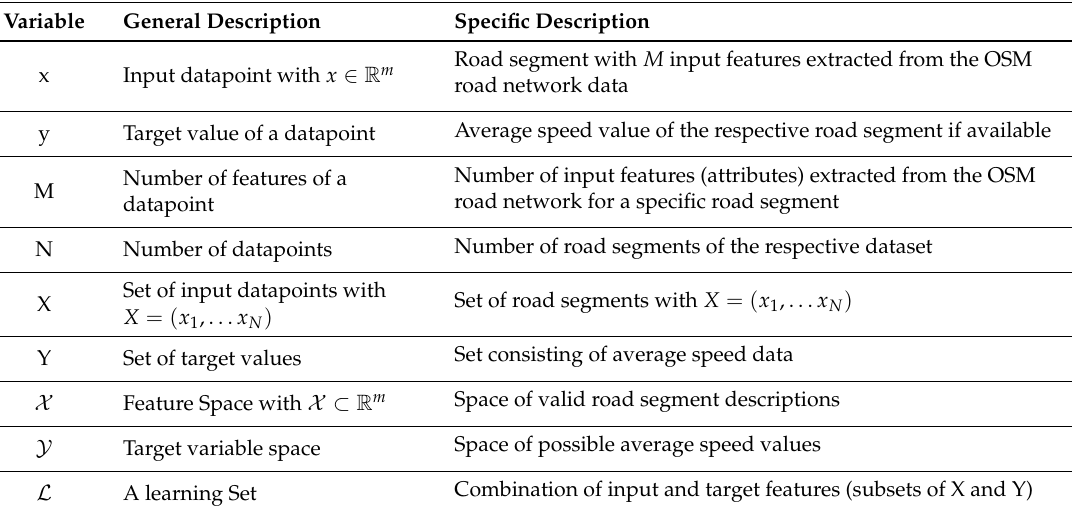
Table A1. Variable naming conventions of our estimation framework.